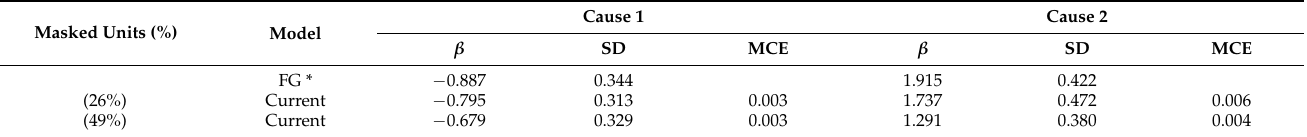
Table 1. Estimated Regression Coefficients.